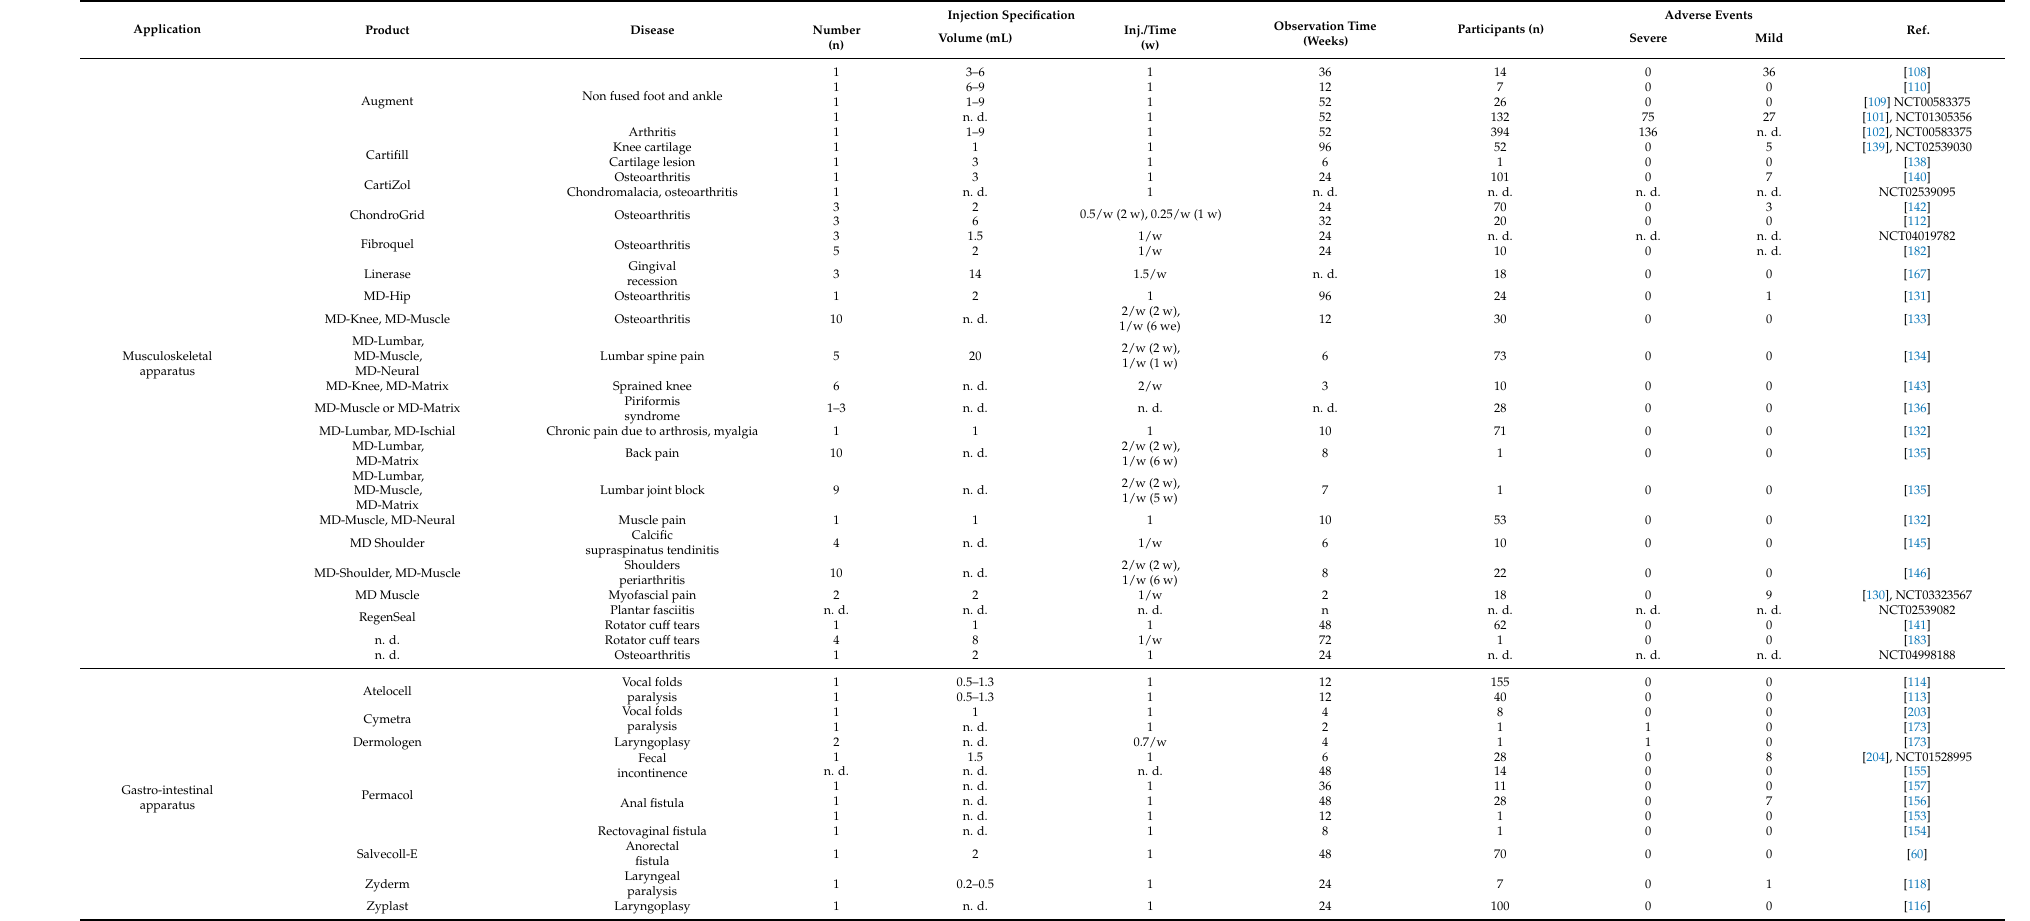
Table 5. Collagen injection specifications (number, volume and time), adverse events recurrence (severe and non-severe) and other details from most recent